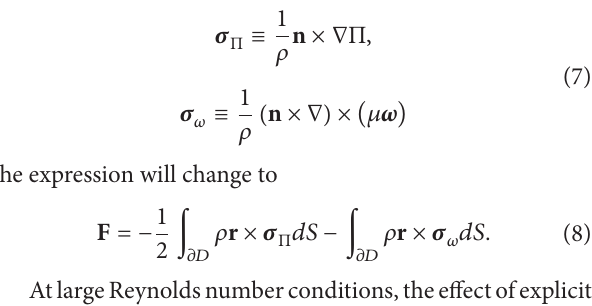
Figure 3: The relation between quasiorthogonal, streamline, and cross-section